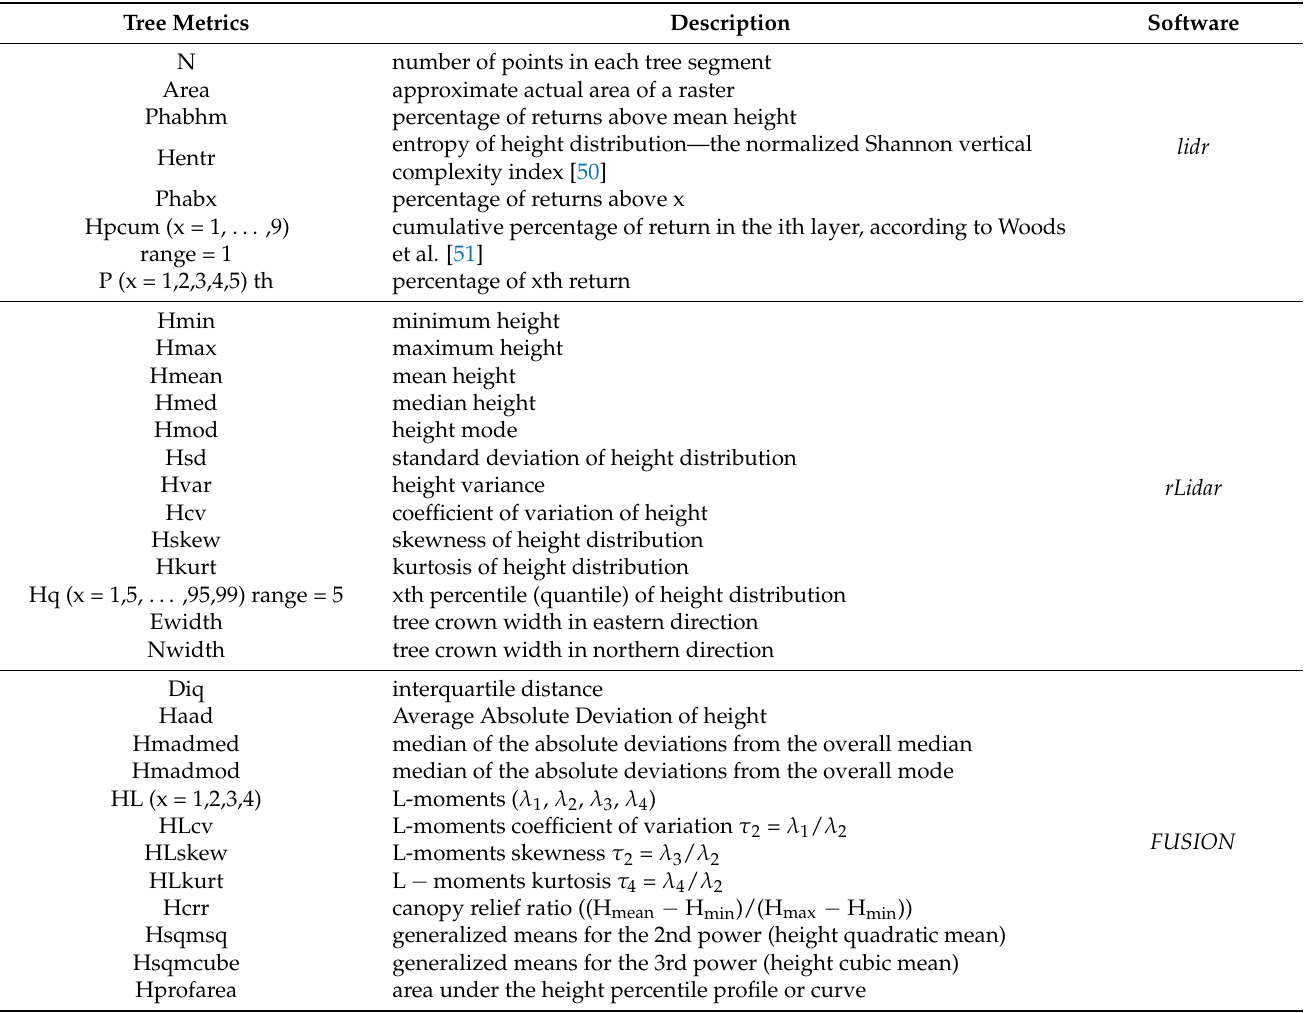
Table 1. Overview of the tree metrics.